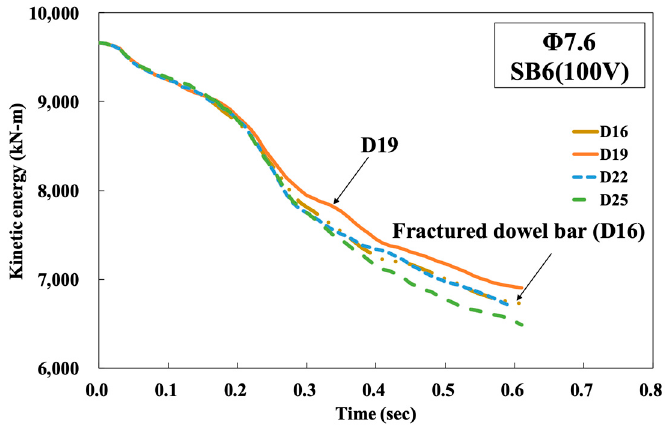
Figure 6. Obtained volume loss depending on the size of wire-mesh under SB6 impact severity. ( a ) Volume loss ratio of ø7.6 wire-mesh under SB6(100V); ( b ) lateral displacement and longitudinal length (ø7.6) under SB6(100V).